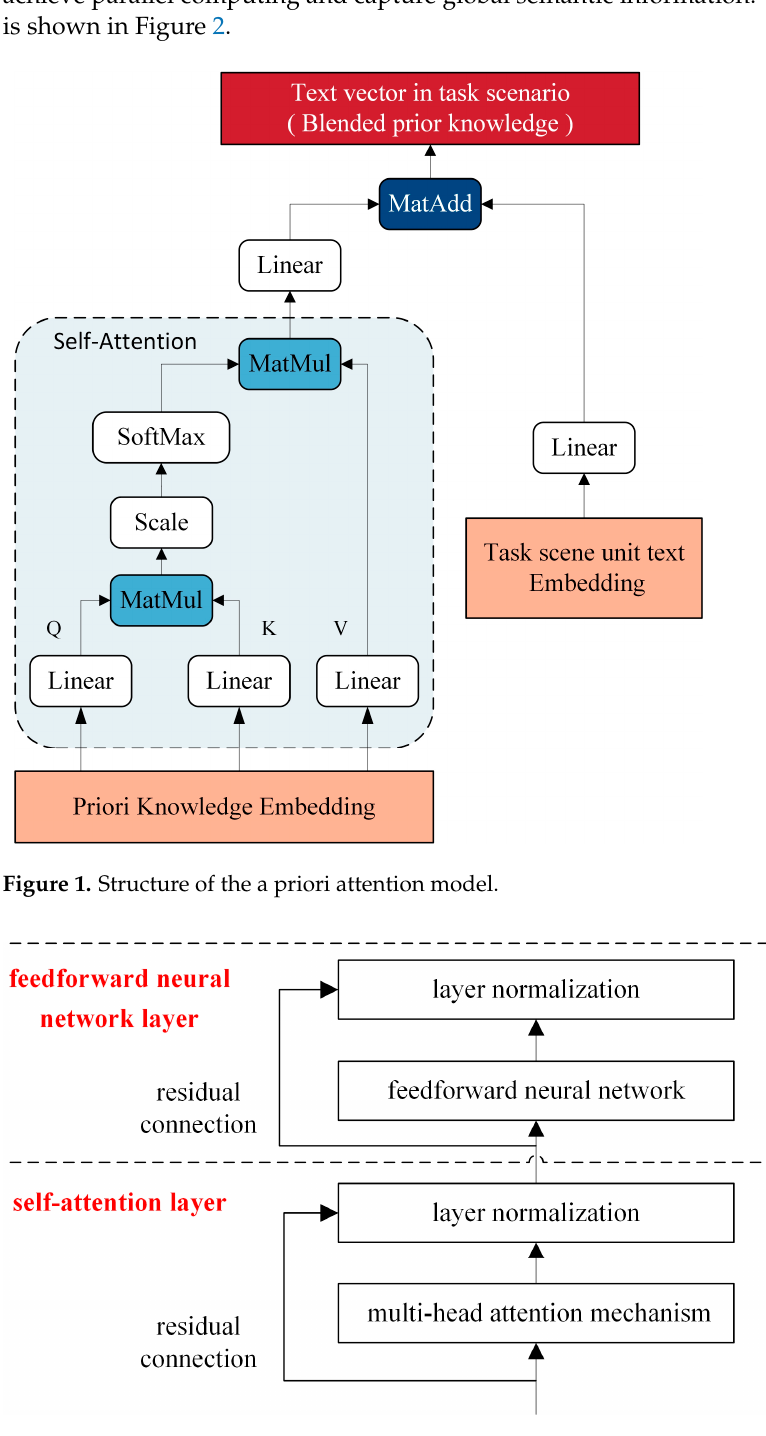
Figure 2. Transformer encoder structure diagram.